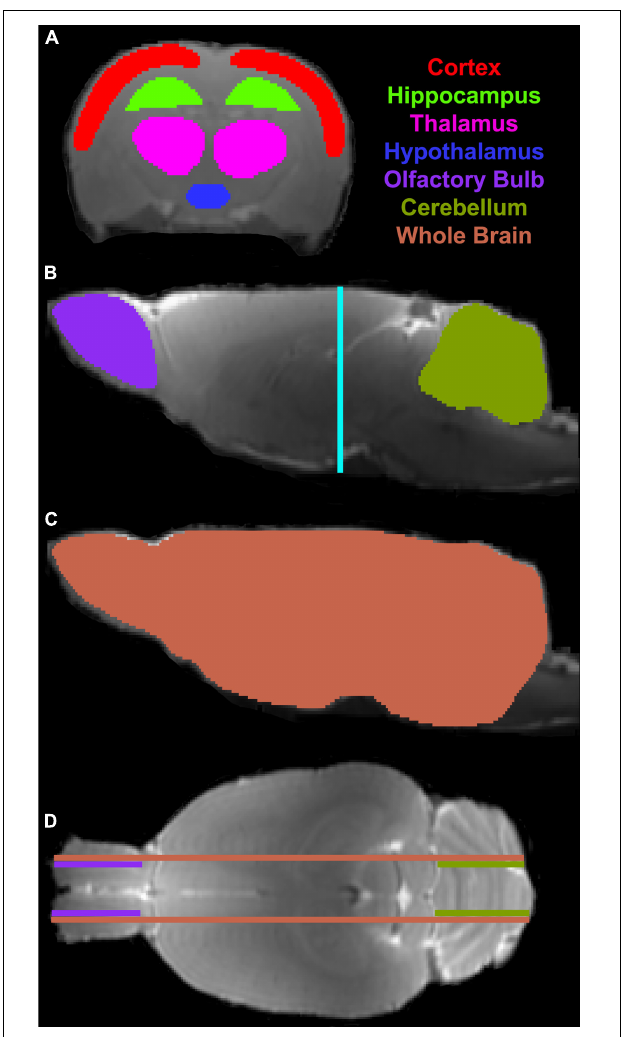
FIGURE 2 | Regions of interest (ROIs) (colored anatomical areas in A–C ) on the coronal ( A , Bregma -3.00 mm) and sagittal ( B,C , Lateral 0.40 mm) sections, and their corresponding locations on the sagittal ( B , light blue line) and axial ( D , purple, olive and coral lines, Interaural 5.72 mm) sections, respectively.